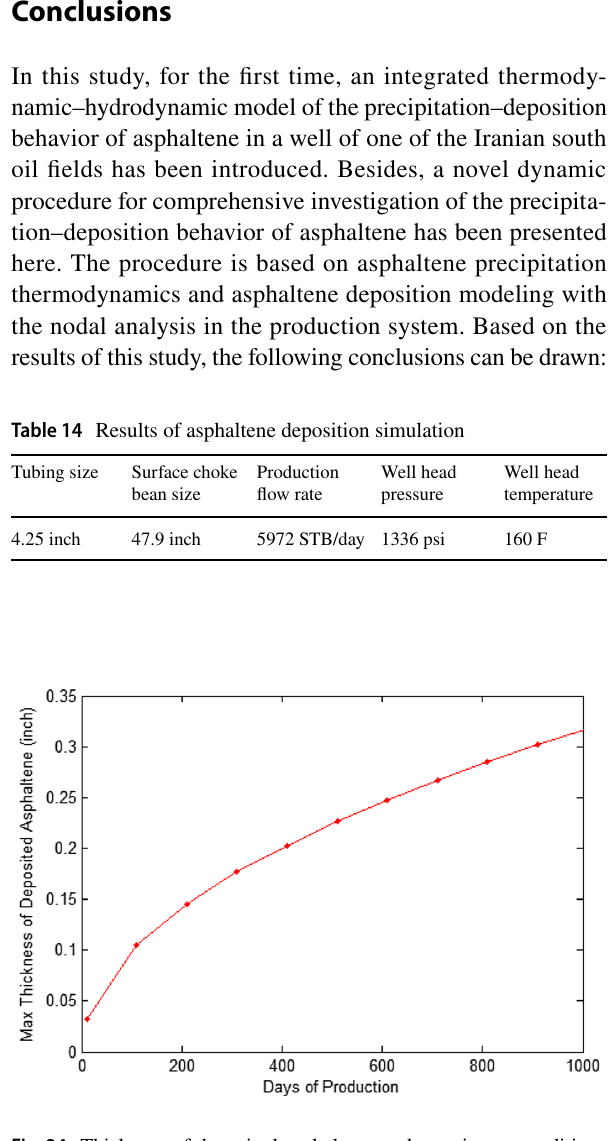
Fig. 23 Flowchart of cumulative production calculation